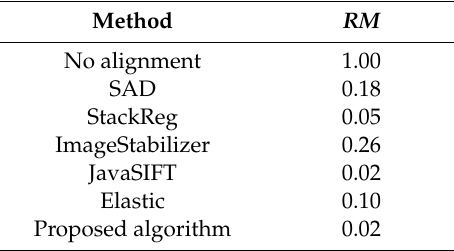
Figure 16. The displacements found by various algorithms for sample B: ( a ) in the X axis; ( b ) in the Y axis.